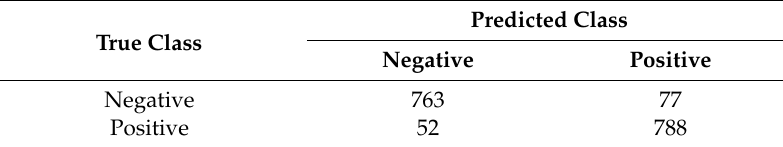
Table 6. Deep FC1 features and NB classifier.